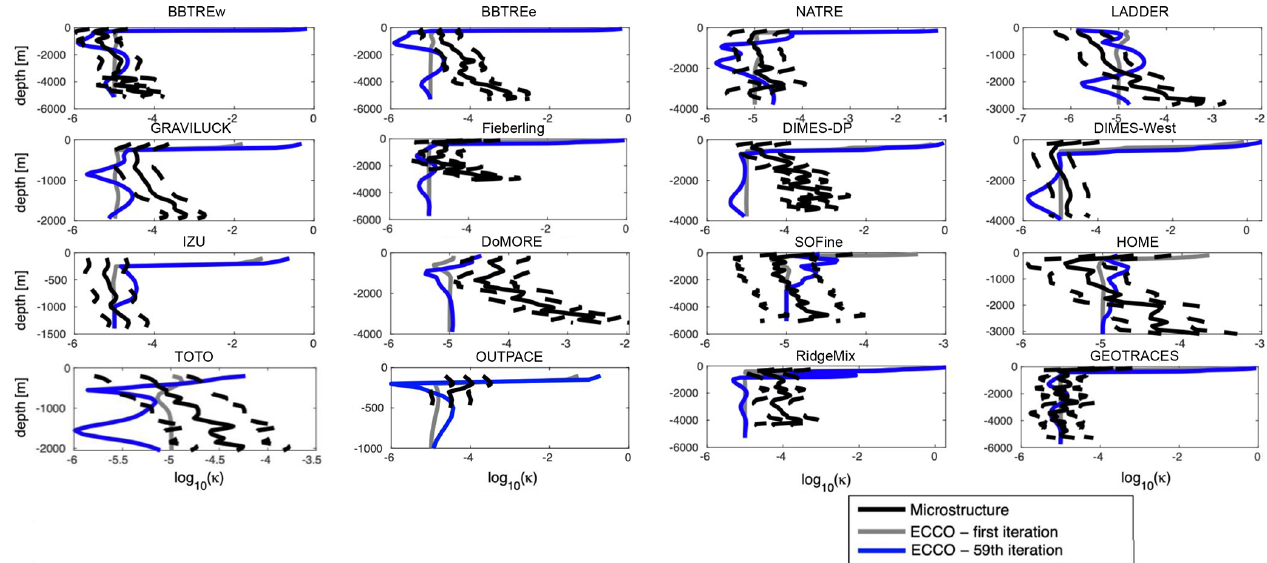
Figure 5. In each panel, κ ρ profiles are shown averaged over 16 example microstructure observation campaigns (see Fig. 2): from the first iteration of the optimization ( E -CTRL 0 – grey curve), from the (final) 59th iteration of the optimization ( E -CTRL – blue curve), and from the full-depth microstructure observations (black curve) presented in Waterhouse et al. (2014) (see their Fig. 6). Approximate factor of 3 uncertainties flanking the κ ρ profiles from microstructure are shown with dashed black